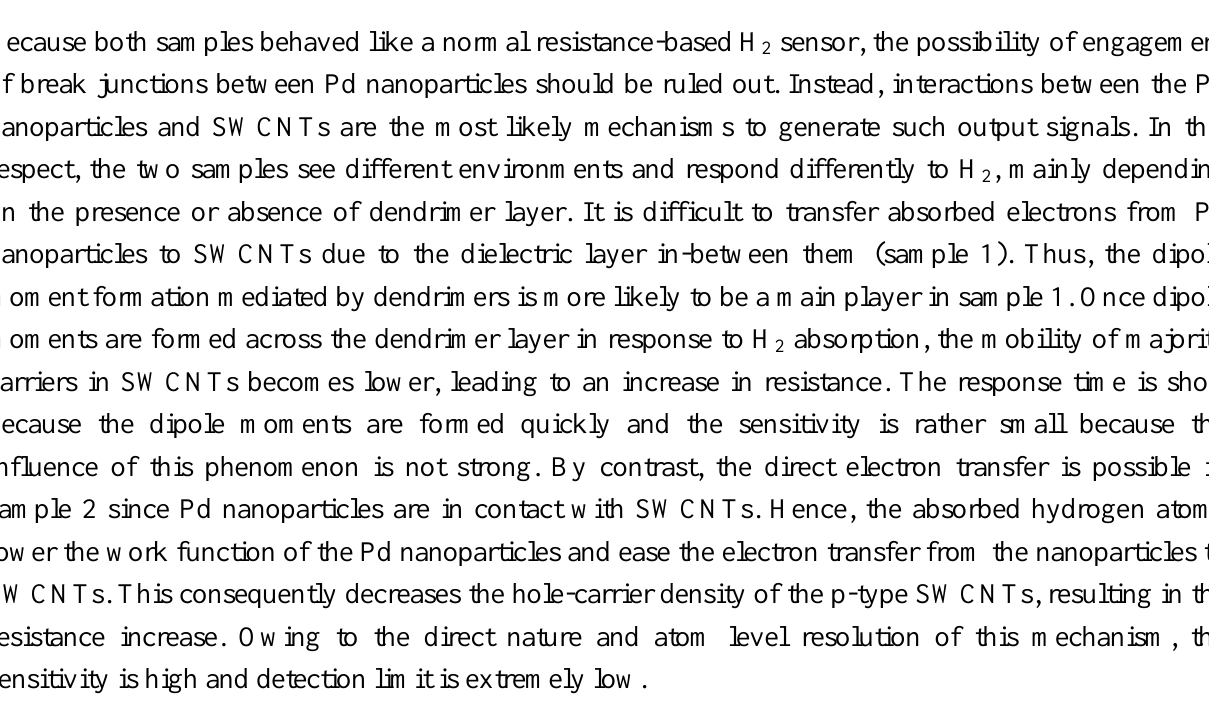
Figure 14. (a) Schematic pictures and (b) transmission electron microscopy (TEM) images of two types of Pd nanoparticle samples grafted on